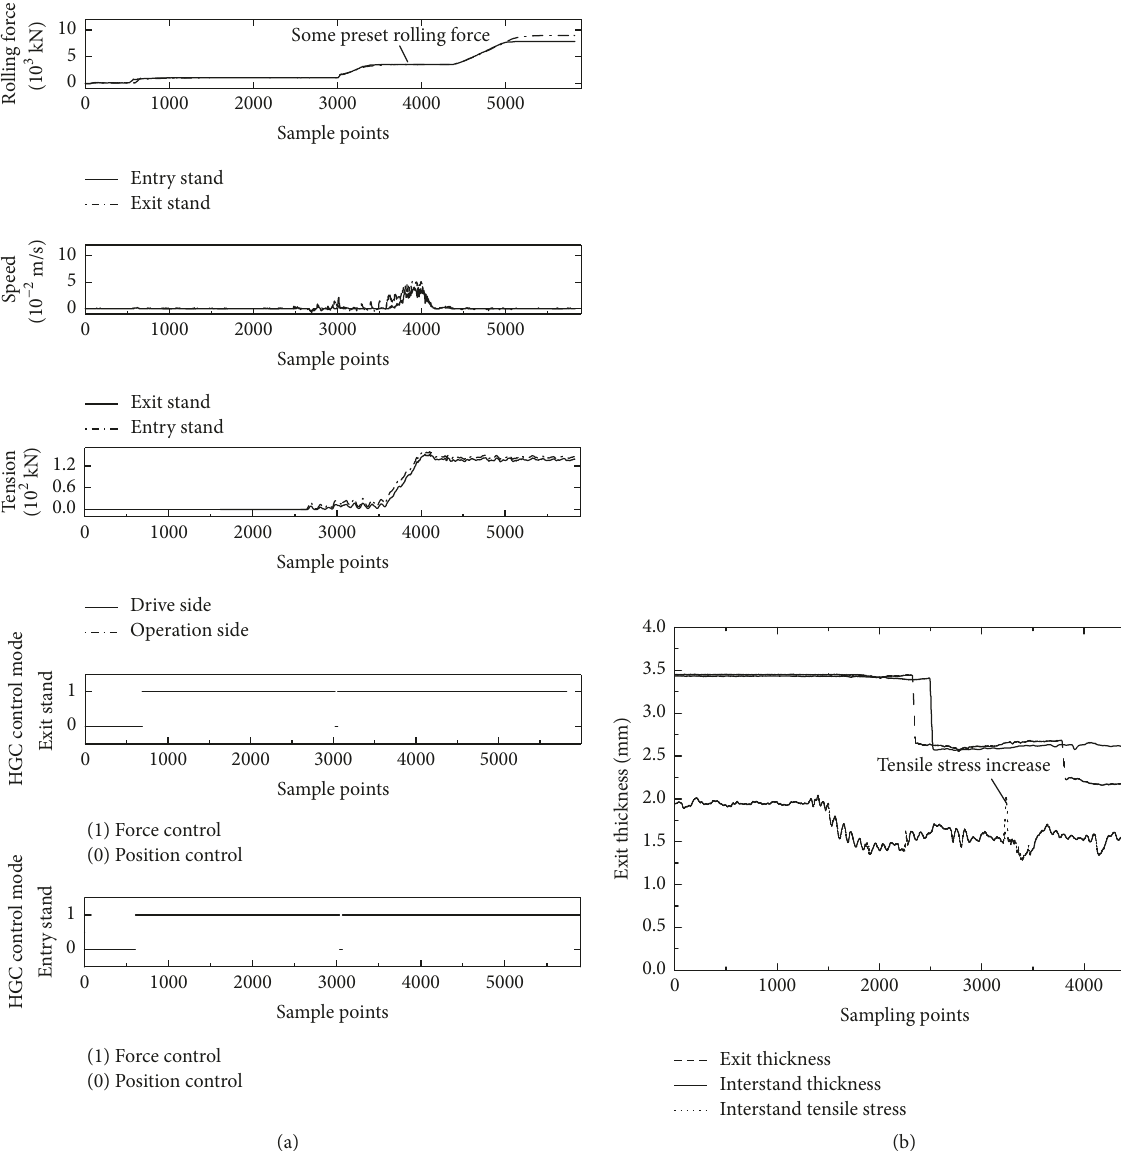
Figure7:Newtensionestablishingprocess,thickness,andtensilestressvariationsofmodifiedstartupprocess:(a)schematicofnewinterstand tension establishing process; (b) tensile stress and thickness